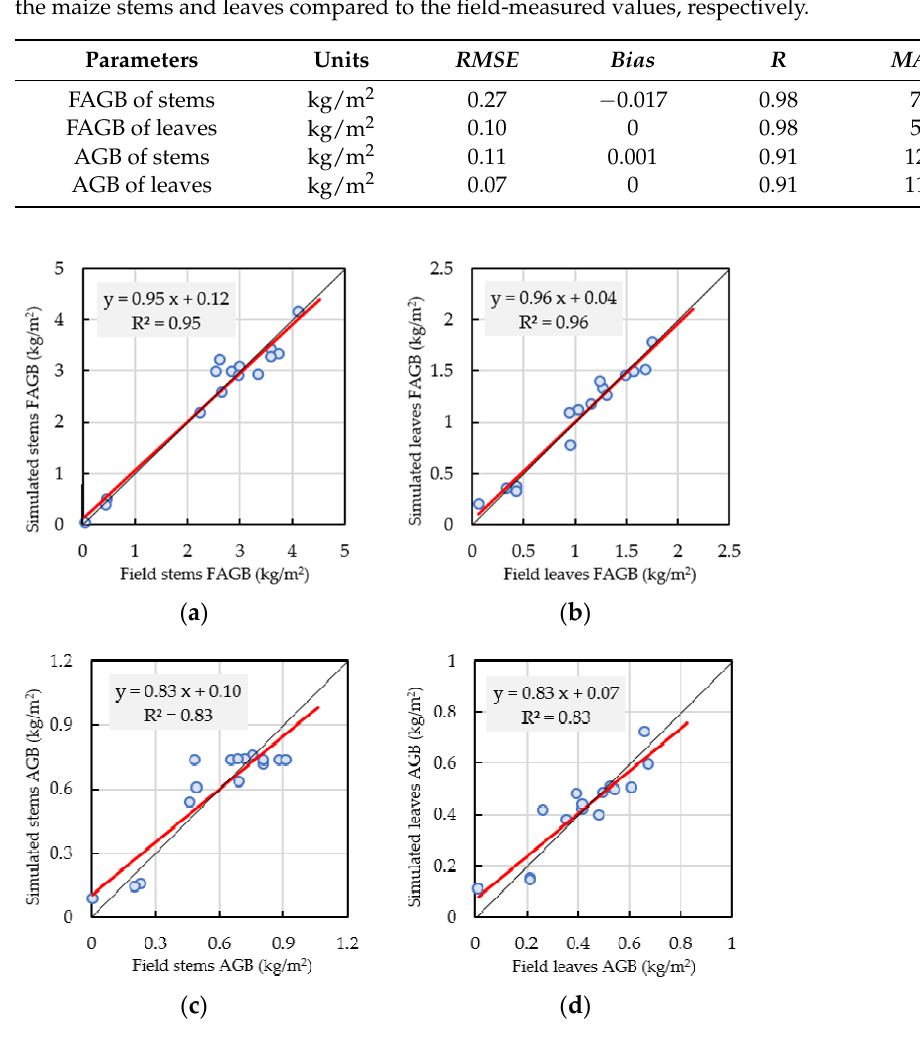
Figure 6. The results of the comparison between the simulated values of the FAGB and AGB of the maize stems and leaves with the field observations, respectively. ( a ) Stem and ( b ) leaf of FAGB, ( c ) stem and ( d ) leaf of AGB. Table 4. The simulation accuracy indicator results for the FAGB and AGB in the simulated values of the maize stems and leaves compared to the field-measured values, respectively.